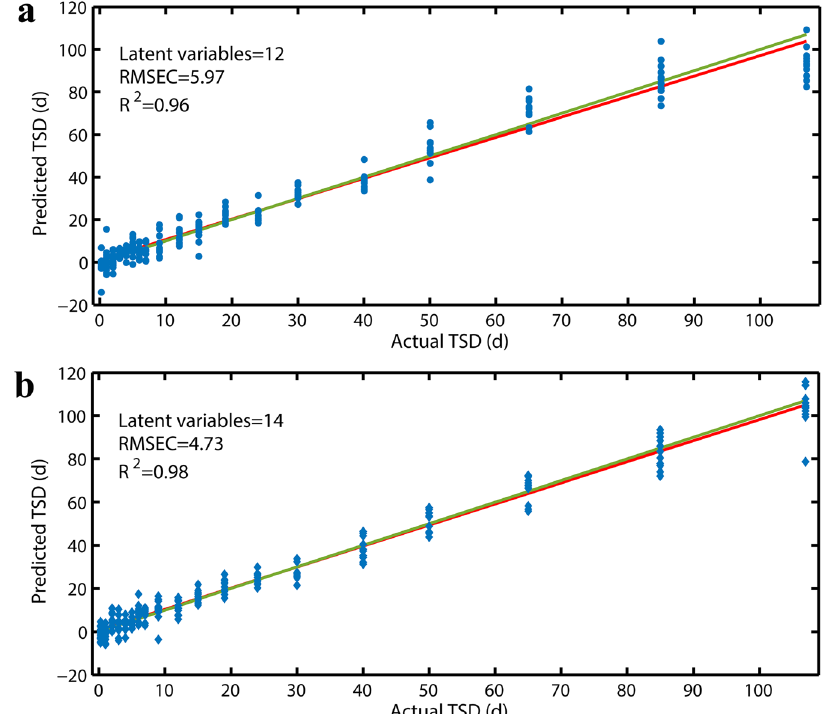
Figure 2. PLSR plots for ( a ) indoor and ( b ) outdoor bloodstain samples in the 0.25- to 107-d period showing the calibrated age predictions versus the actual age.